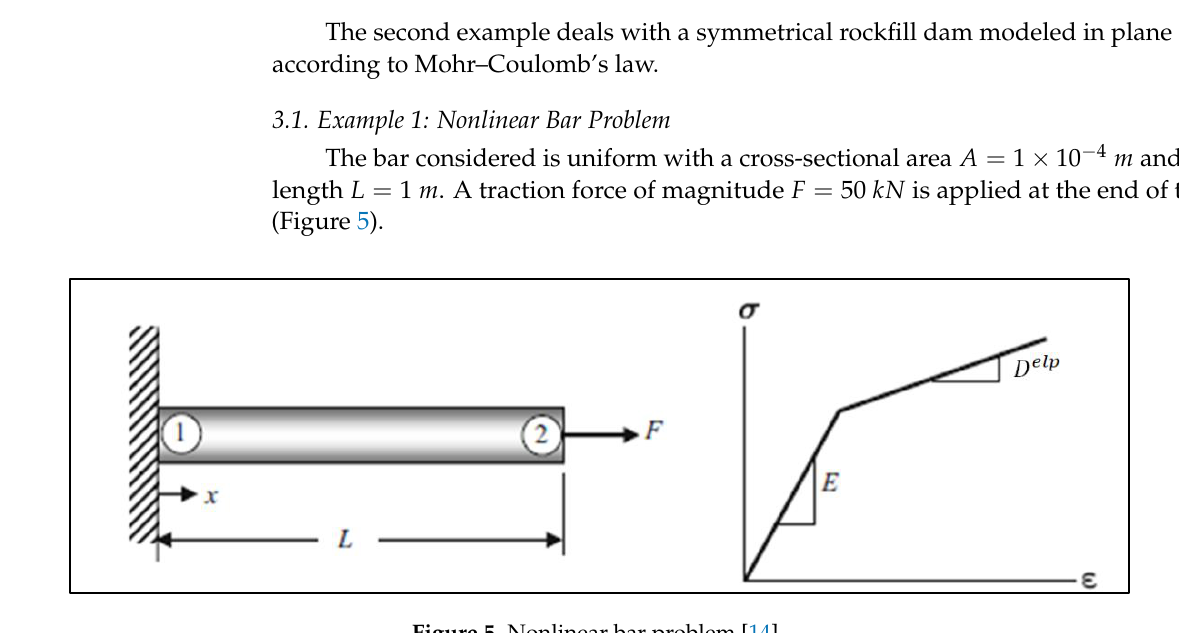
Table 1. Convergence rate and number of iterations by loading: 1D case. Convergence: ‖𝑭 𝒆𝒙𝒕 −𝑭 𝒊𝒏𝒕 ‖ ‖𝑭 𝒆𝒙𝒕